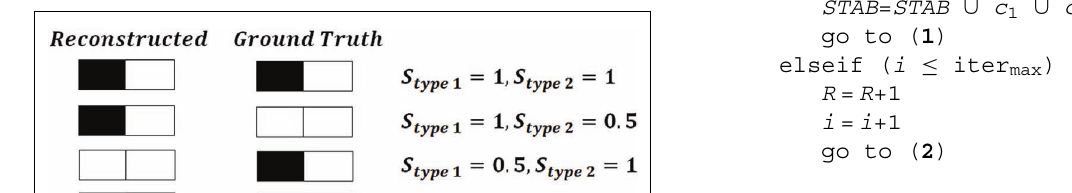
FIGURE 6 | Similarity factors for all data sets, from left to right respectively: olfactory projection fibers: OP1, OP2, OP3, neocortical layer 6 axons, cerebellar climbing fibers, and hippocampal CA3 interneuron.